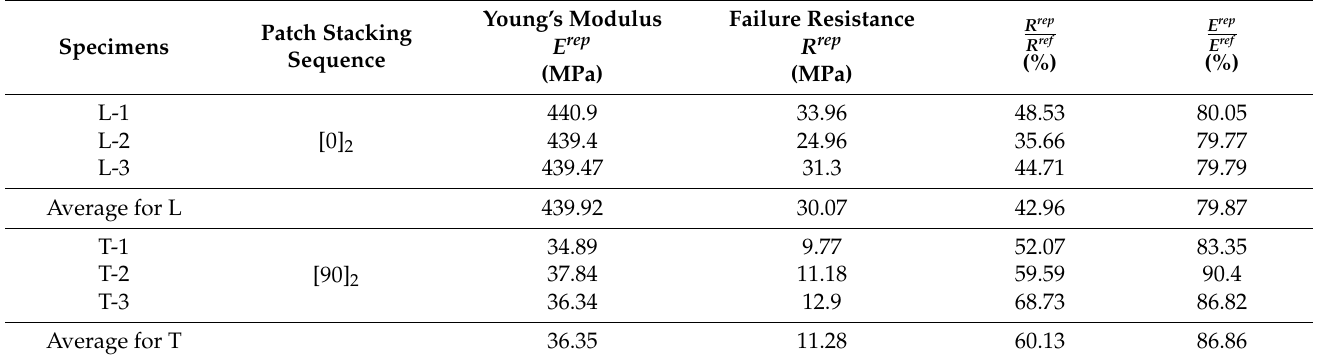
Figure 11. Comparison of the tensile behavior of the heathy and repaired specimens by the cold polymerization process: ( a ) in a longitudinal direction ( b ) in a transverse direction. Table 6. Repairing performance for both longitudinal and transverse